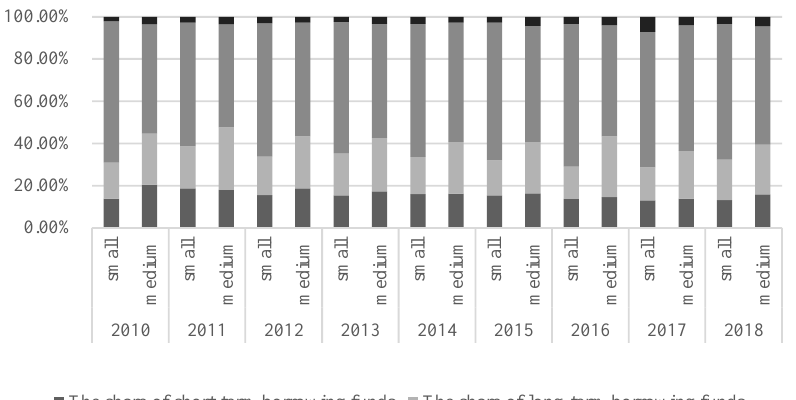
Source: own calculations based on Russian Federal State Statistics Service data. Figure 2. Borrowed funds structure of Russian manufacturing SMEs in years 2010–2018